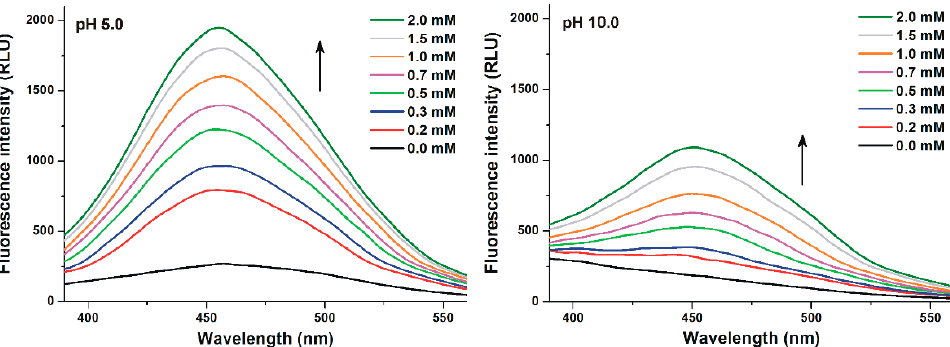
Figure 4. Fluorescence emission spectra of Z14G (1 µM) in the presence of increasing concentrations of RAMEG (0.0–2.0 mM) in 0.05 M sodium acetate (pH 5.0; left) and in 0.05 M sodium borate (pH 10.0; right) buffers ( λ ex = 315 nm).